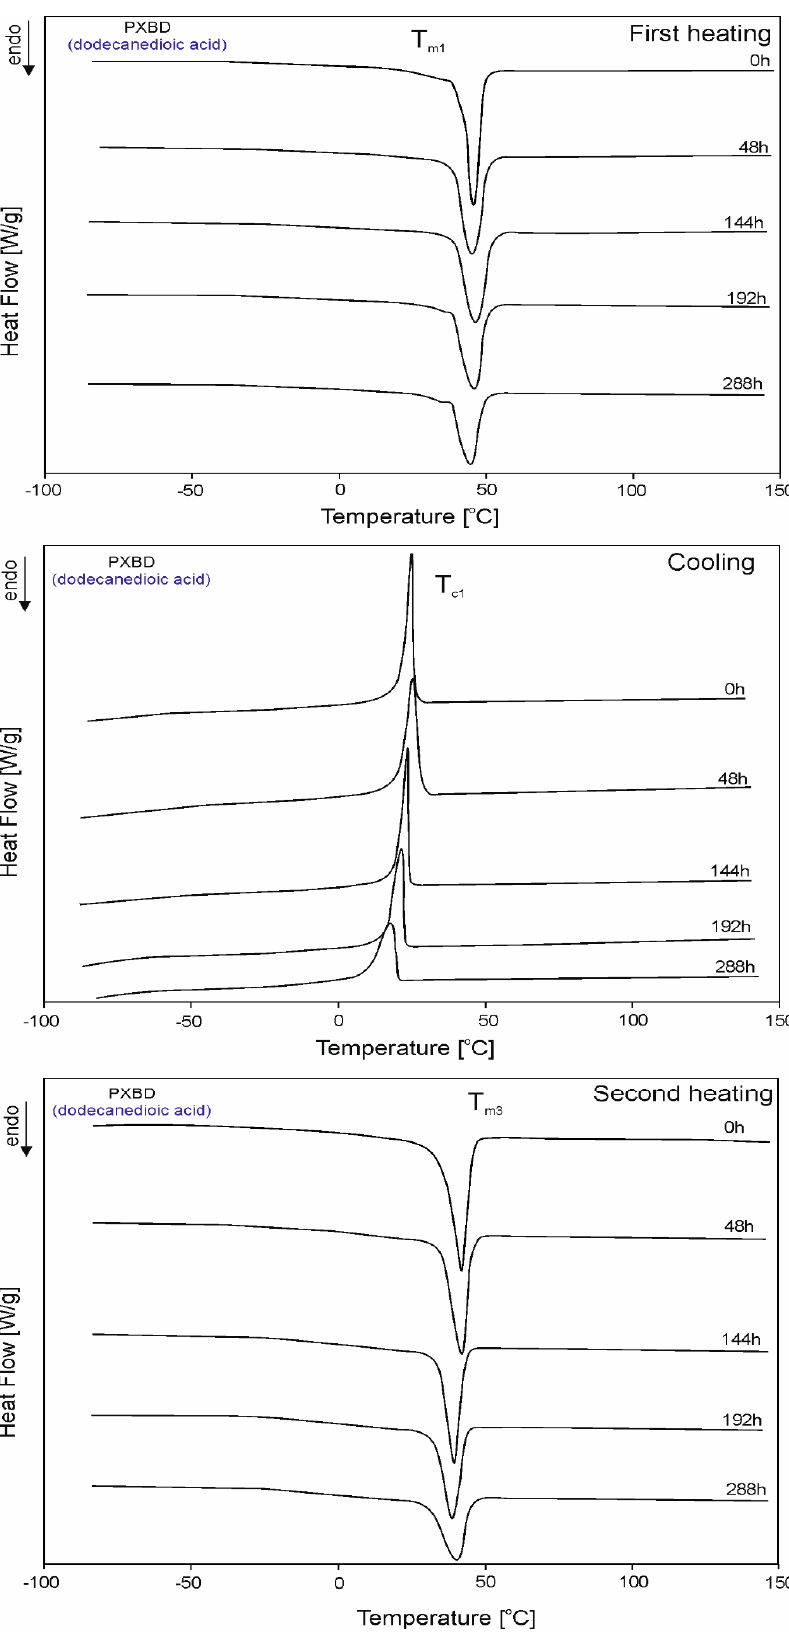
Figure 9. DSC thermograms of PXBD at the crosslinking stages subjected to first heating, second heating and cooling.